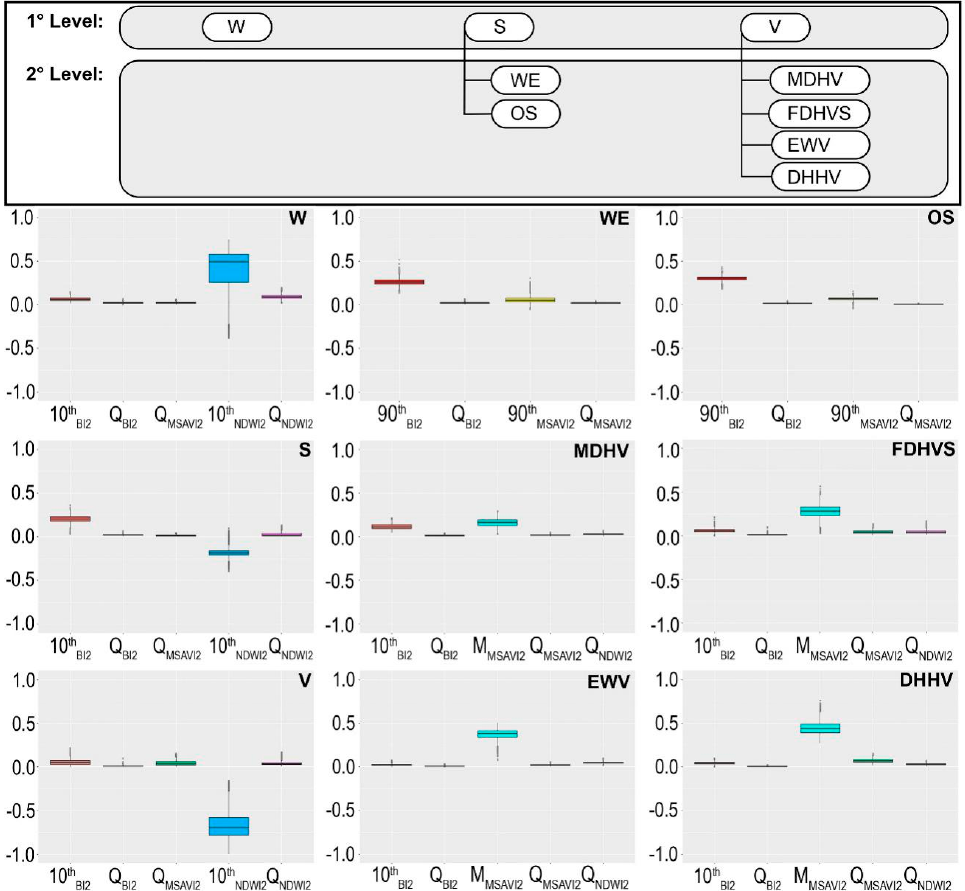
Figure 4. Scheme of the obtained natural and semi-natural cover classes (in the top) along with the respective boxplots showing variables’ values. Reported variables are those selected by VIF analysis and used for classification on each cycle. Classes are: Water (W), Sand (S), Vegetation (V), Water Edge (WE), Open Sand (OS), Mobile Dune Herbaceous Vegetation (MDHV), Evergreen Woody Vegetation (EWV), Deciduous and Humid Herbaceous Vegetation (DHHV), Fixed Dune Herbaceous Vegetation with Sparse Shrub (FHVSS). Variables are Q NDWI2 : temporal Rao of NDWI2, Q BI2 : temporal Rao of BI2, Q MSAVI2 : temporal Rao of MSAVI2 , 10 thNDWI2 : 10th percentile of NDWI2 , 10 thBI2 : 10th percentile of BI2, 90 thBI2 : 90th percentile of BI2, 90 thMSAVI2 : 90th percentile of MSAVI2, M MSAVI2 : mean of MSAVI2.